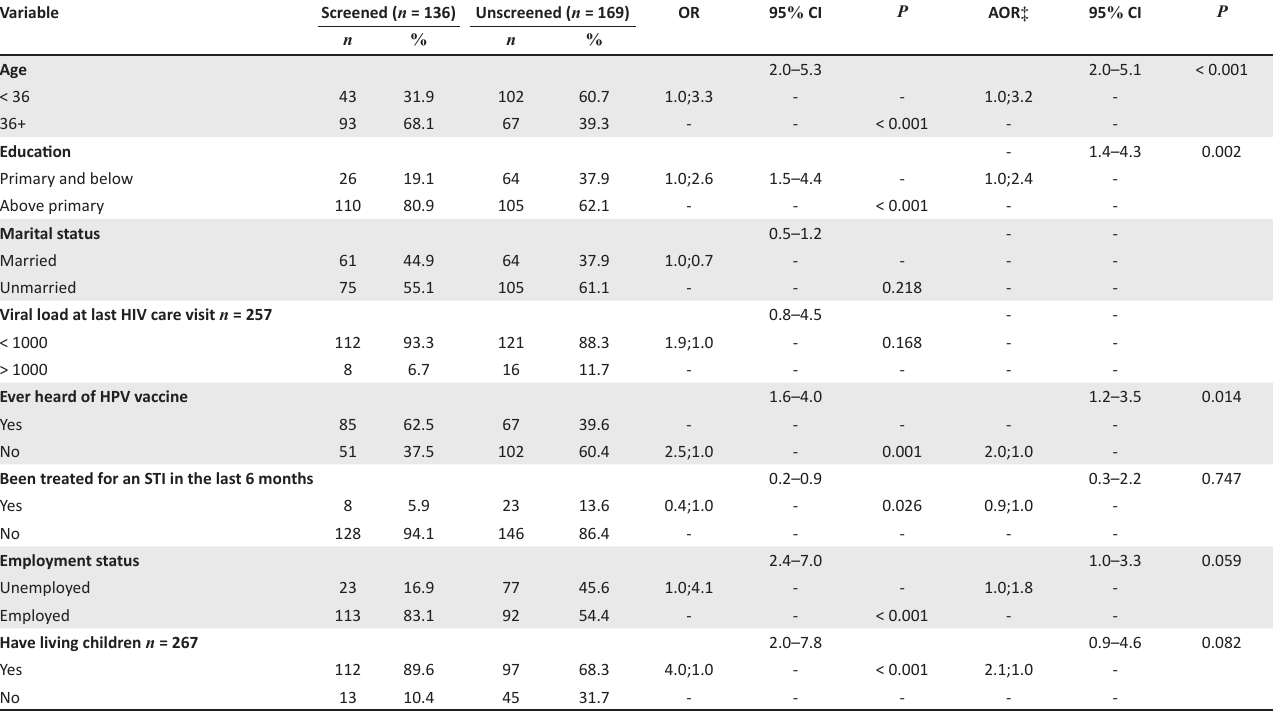
TABLE 2: Correlates of the utilisation of cervical cancer screening services among women living with HIV. † 5